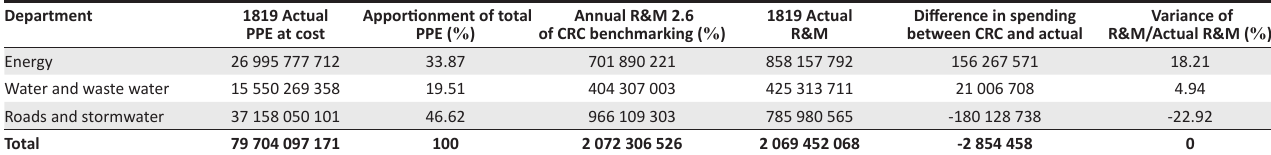
TABLE 5: Comparison between the City of Ekurhuleni’s repairs and maintenance and that of international benchmarking for the 2018–2019 financial year. Department 1819 Actual PPE at